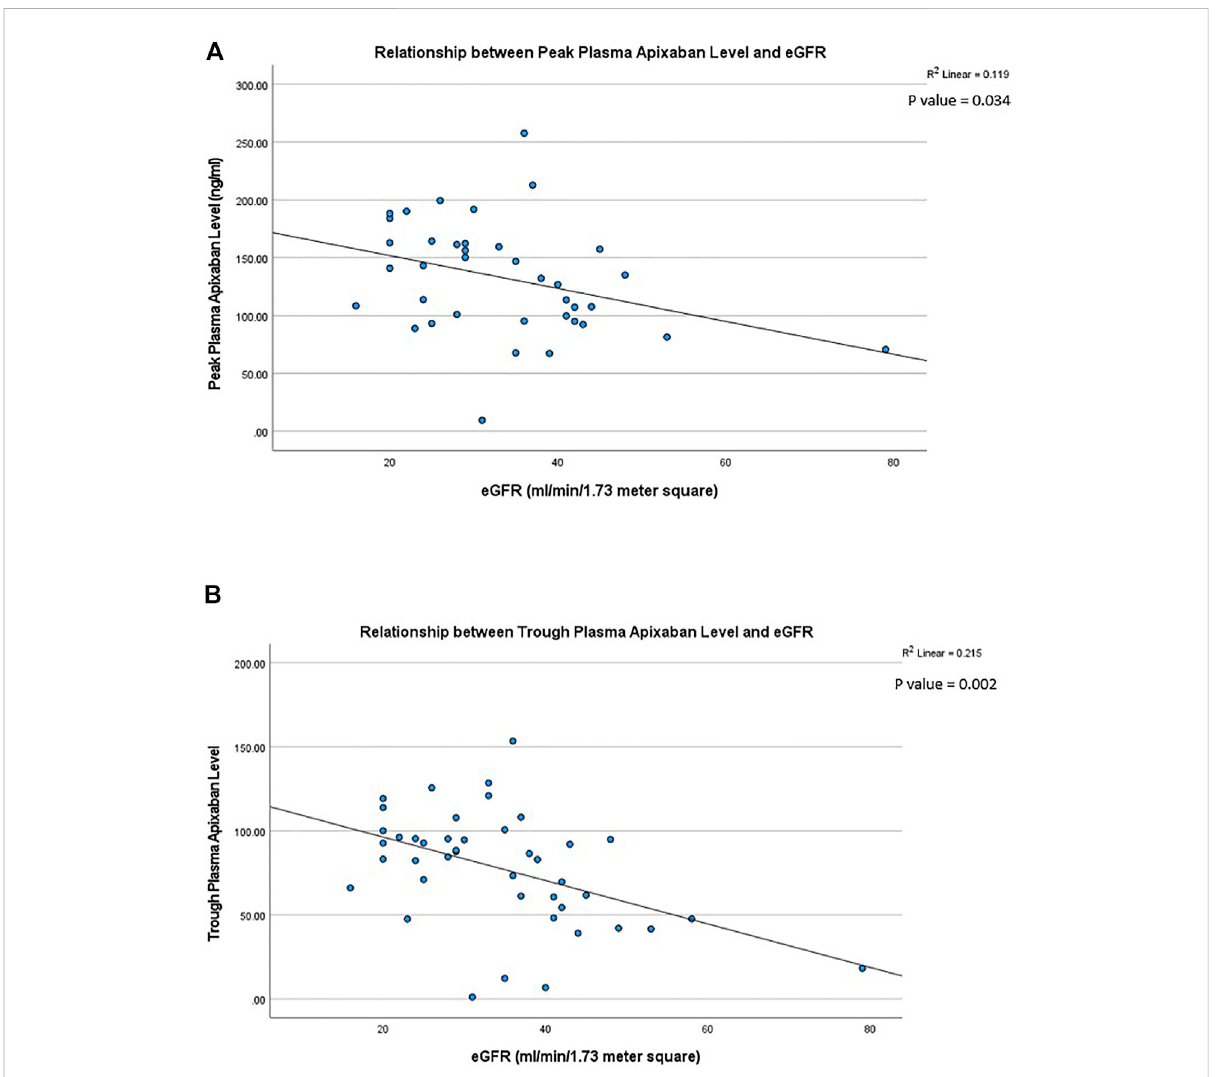
FIGURE 3 (A) Relationship between peak plasma apixaban level and creatinine clearance at 2.5 mg twice daily. The peak plasma apixaban level was negatively correlate with creatinine clearance ( r 2 : − 0.119, p < 0.05) ( r 2 : coef fi cient of determination). (B) Relationship between trough plasma apixabanlevelandcreatinineclearanceat2.5 mgtwicedaily.Linearregressionanalysisshowedthatthetroughplasmaapixabanlevelwasnegatively correlate with creatinine clearance ( r 2 : − 0.215, p < 0.05) ( r 2 : coef fi cient of